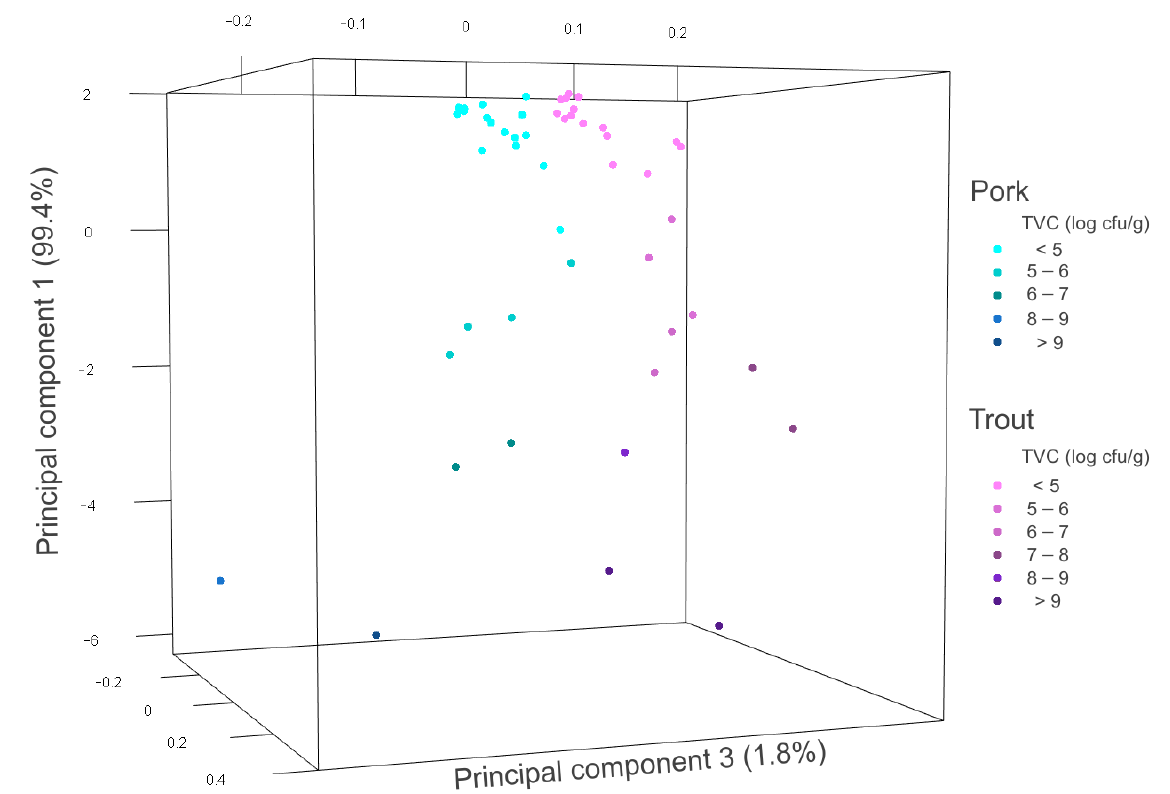
Figure 6. Principal component analysis of meat and fish samples over time. Shades of blue (cyan to navy) indicate points for pork samples, while shades of purple (pink to violet) indicate points for marble trout samples.